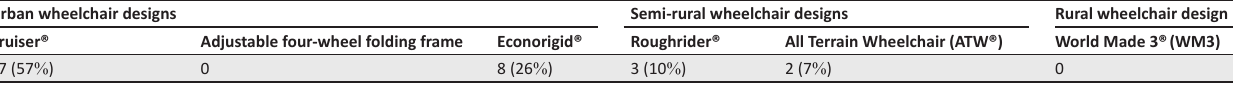
TABLE 2: The type of wheelchair issued to participants ( n = 30)